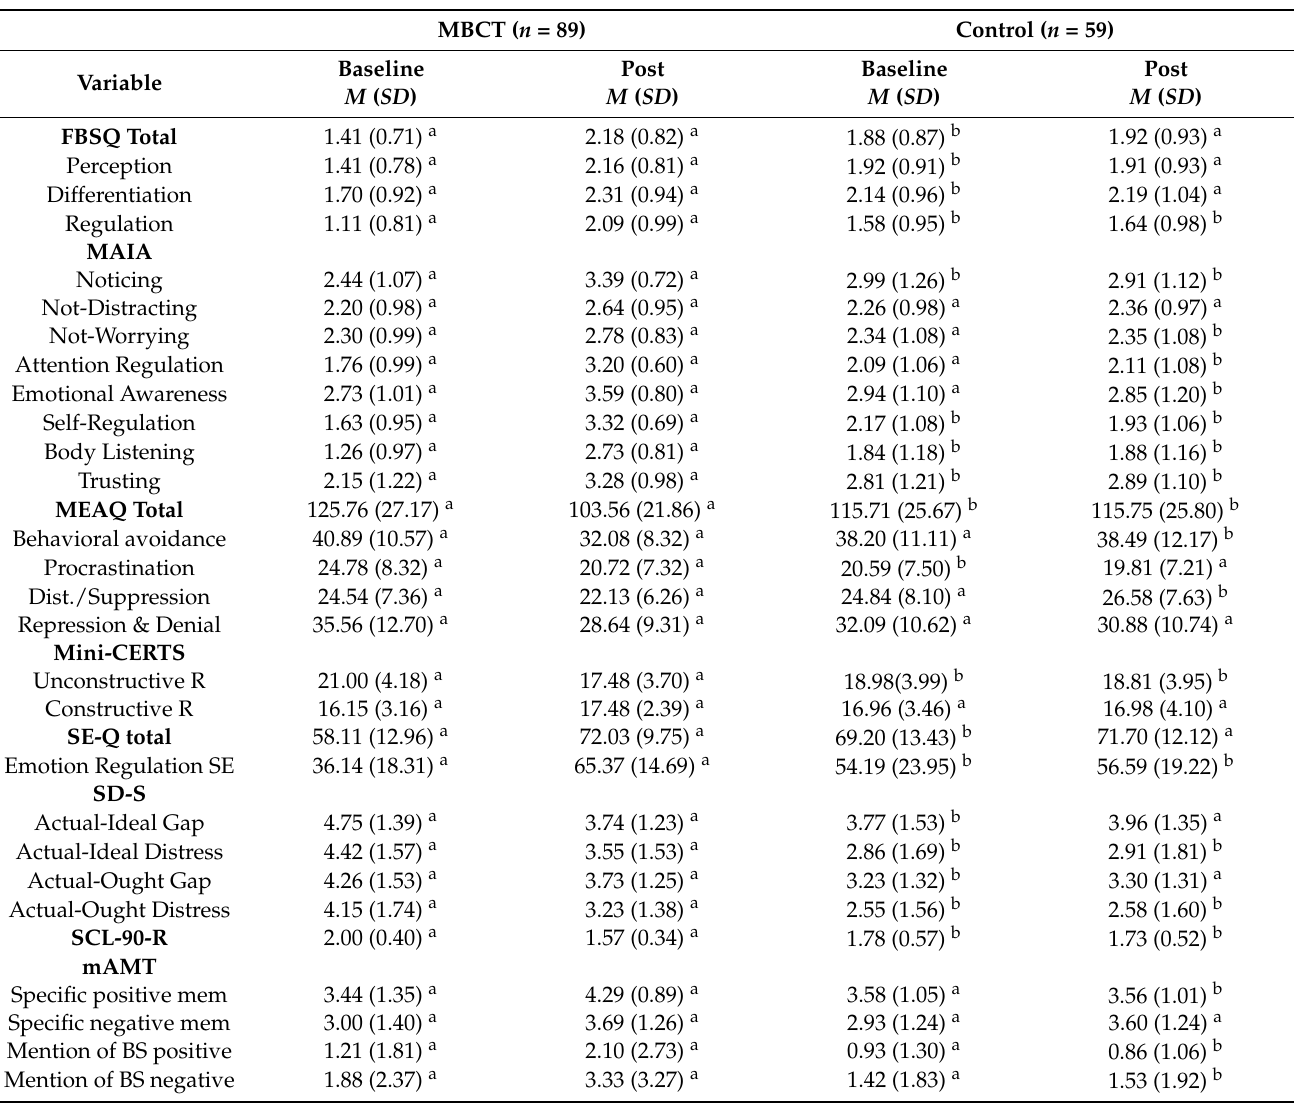
Table 2. Means and standard deviations of variables, stratified by group and measurement occasion.